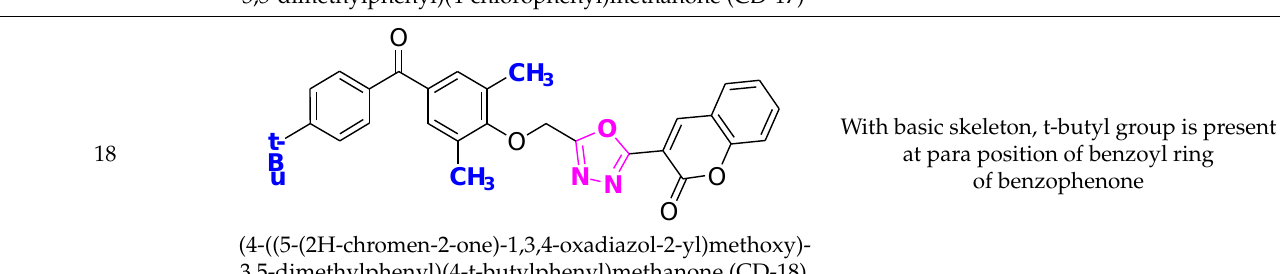
With basic skeleton, t-butyl group is present at para position of benzoyl ring